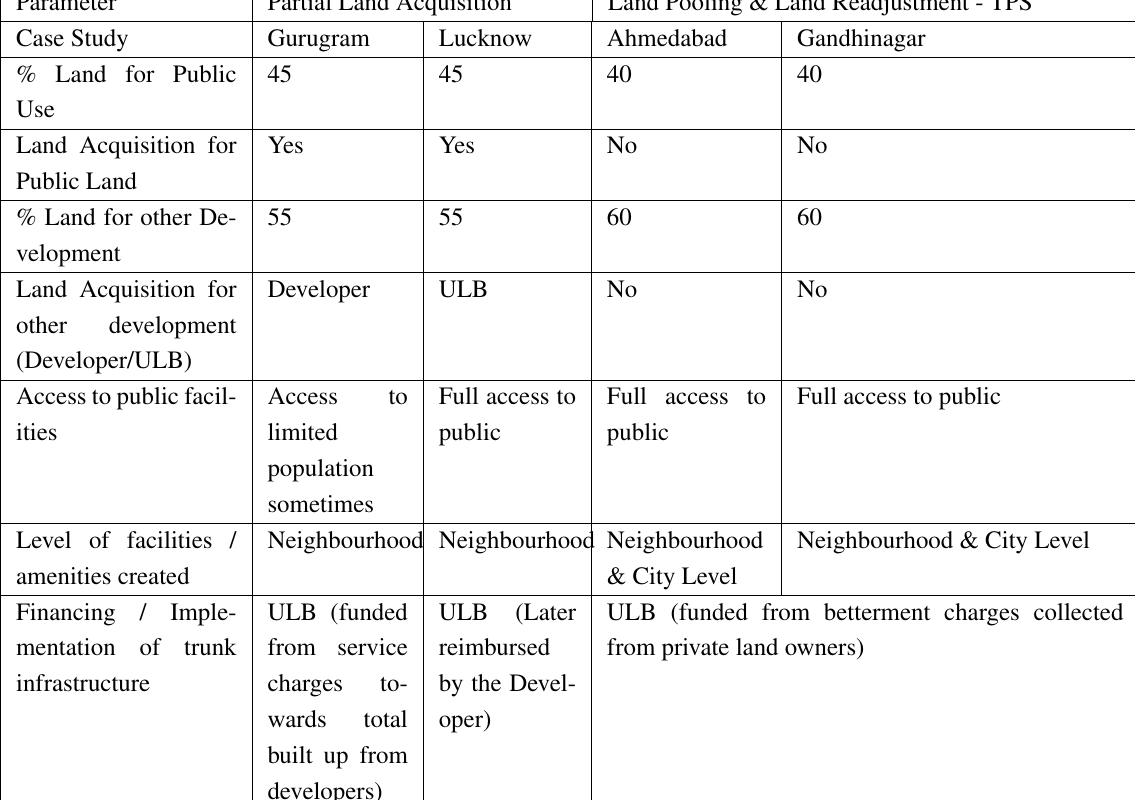
Table 1. Comparative Analysis of Land Development